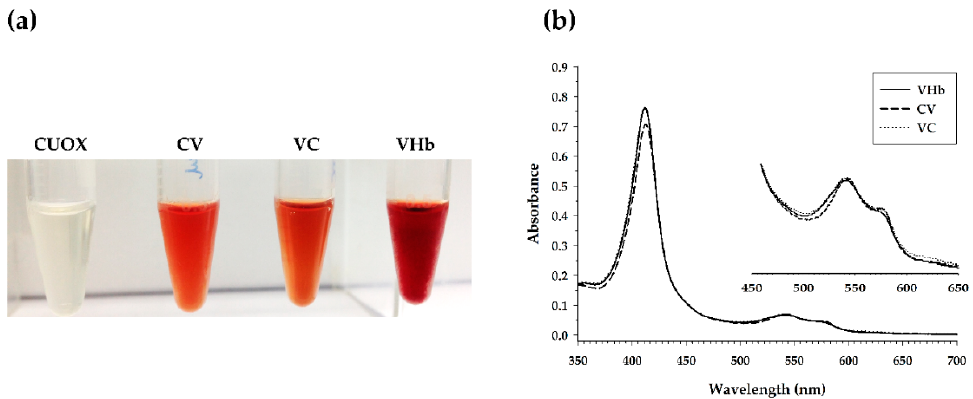
Figure 4. ( a ) The apparent colors of the purified proteins. From left to right: native CUOX, CUOX-VHb fusion protein, VHb-CUOX fusion protein and native VHb. ( b ) UV–vis absorption spectra of the purified proteins (250–700 nm). The Soret peak is represented at 412 nm while the α -bands are represented by the peak between 540 and 577 nm.